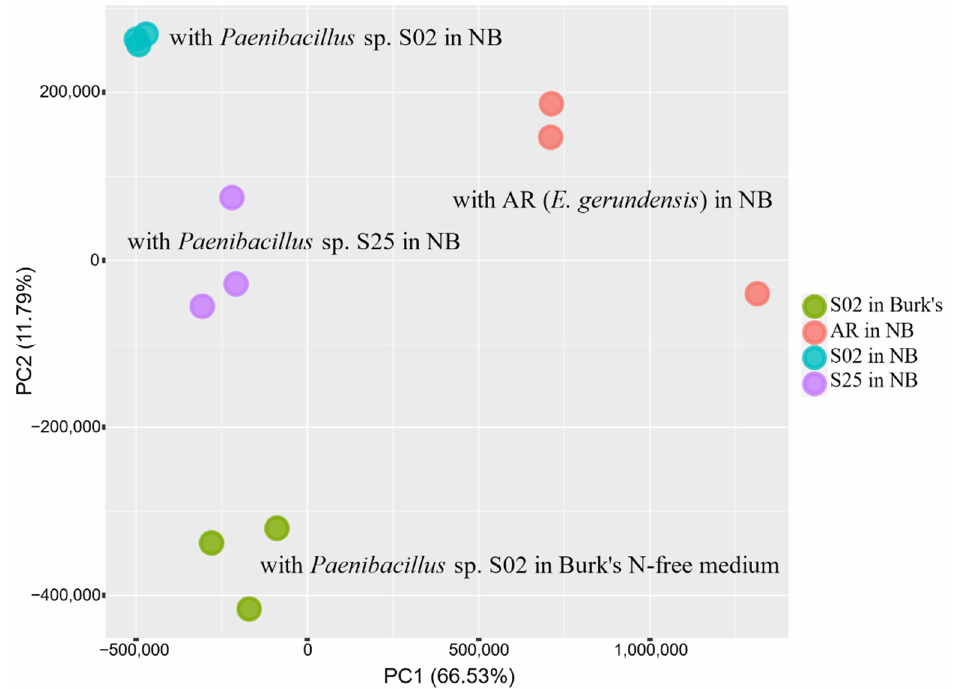
Figure 2. Principal component analysis (PCA) plot representing the clustering of biological replicates based on gene expression levels of barley seedling roots. Percentage variance explained by each axis is given in brackets. Seedlings co-incubated with strain AR ( E. gerundensis ) are separated from the seedlings co-incubated with strain S02 and S25 ( Paenibacillus sp.) along the PC1 axis, suggesting the effects of two different bacterial species. Seedlings co-incubated with strain S02 in Burk’s N-free medium are separated from the seedlings co-incubated with bacterial strains in Nutrient Broth along the PC2 axis, suggesting the effects of two different media. Seedlings co-incubated with strains S02 and S25 in Nutrient Broth are also separated, suggesting the effects of different strains of the same species.